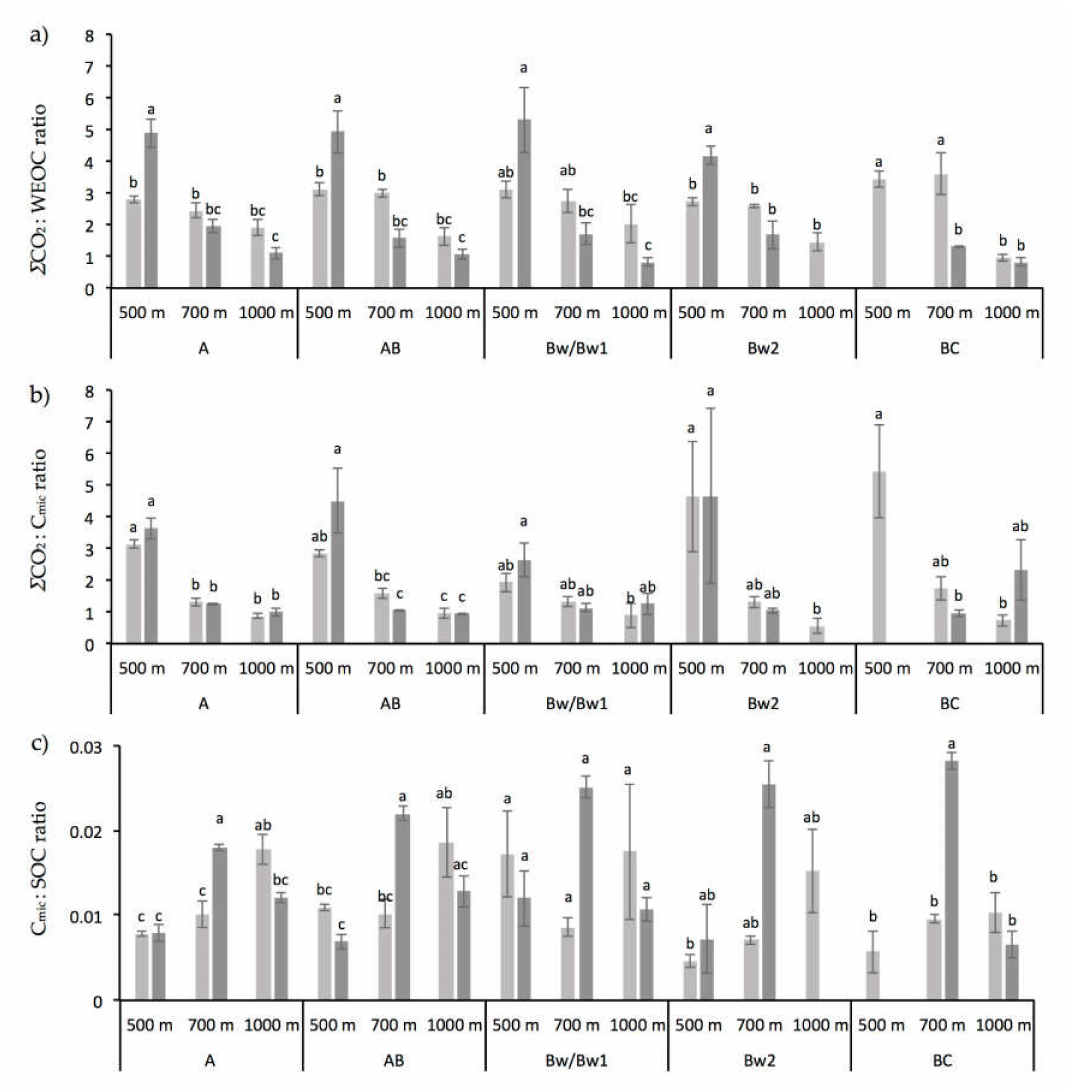
Figure 4. ( a ) Cumulative basal respiration ( Σ CO 2 -C) to water-extractable organic carbon ratio ( Σ CO 2 -C:WEOC ratio), ( b ) Σ CO 2 -C to microbial biomass carbon (Cmic) ratio ( Σ CO 2 -C:Cmic ratio), and ( c ) Cmic to soil organic carbon ratio (Cmic:SOC ratio) for the soils under broadleaf (light bars) and pine (dark bars) forests at 500, 700 and 1000 m a.s.l., Mount Cucco massif (Central Apennines, Italy). Error bars are the standard errors ( n = 3). For each soil parameter and horizon, di ff erent letters indicate significant di ff erences among vegetation types and altitudes according to Tukey’s test ( p <